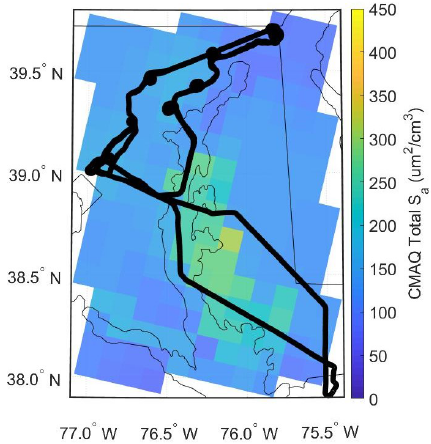
Figure 2. Map of the Baltimore–Washington D.C. area represen- tative of the July 2011 DISCOVER-AQ flights with an example flight path from 28 July 2011. The flight path is overlaid on the CMAQ model grid, showing the modeled surface area in each 12km × 12km grid box at noon EST